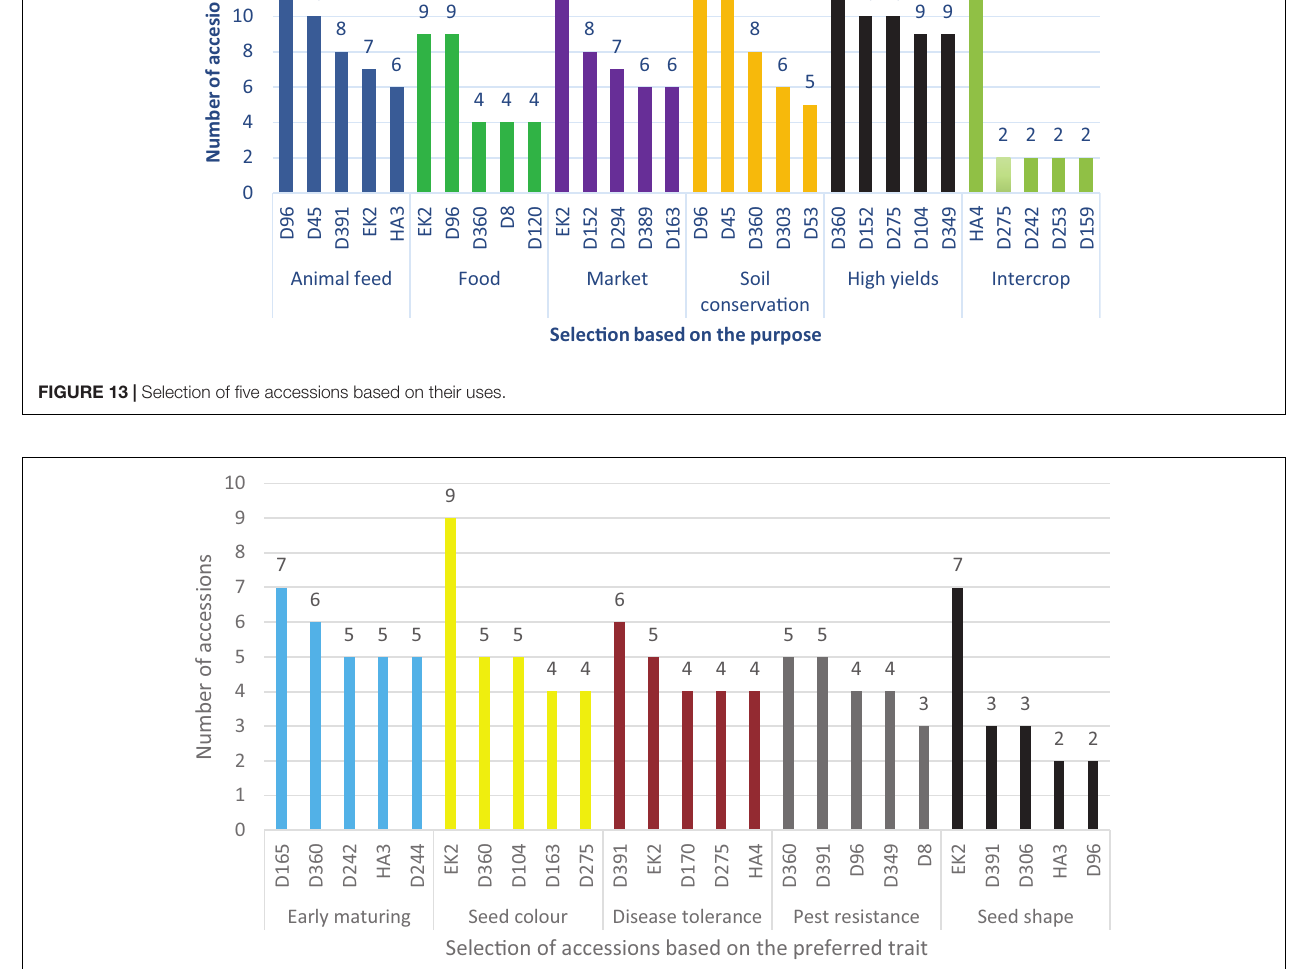
Selec(cid:2)on of accessions based on the preferred trait FIGURE 14 | Selection of five accessions based on preferred